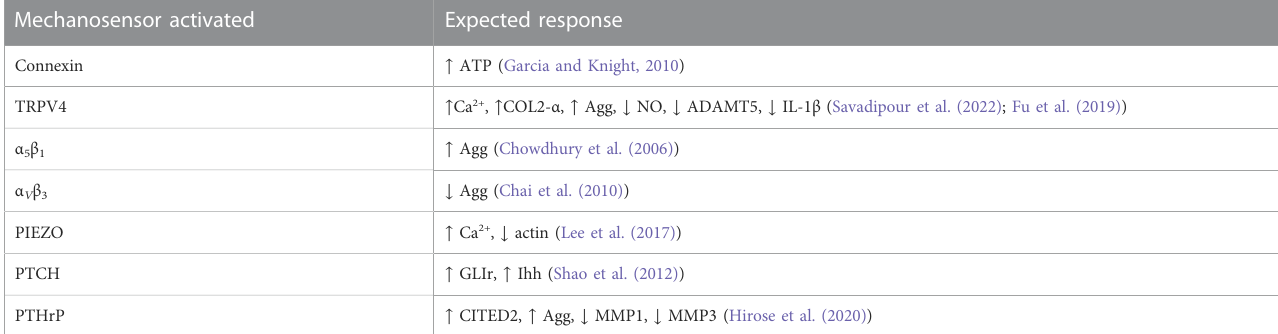
TABLE 2 Qualitative evaluation expected responses for different mechanosensors. Mechanosensor